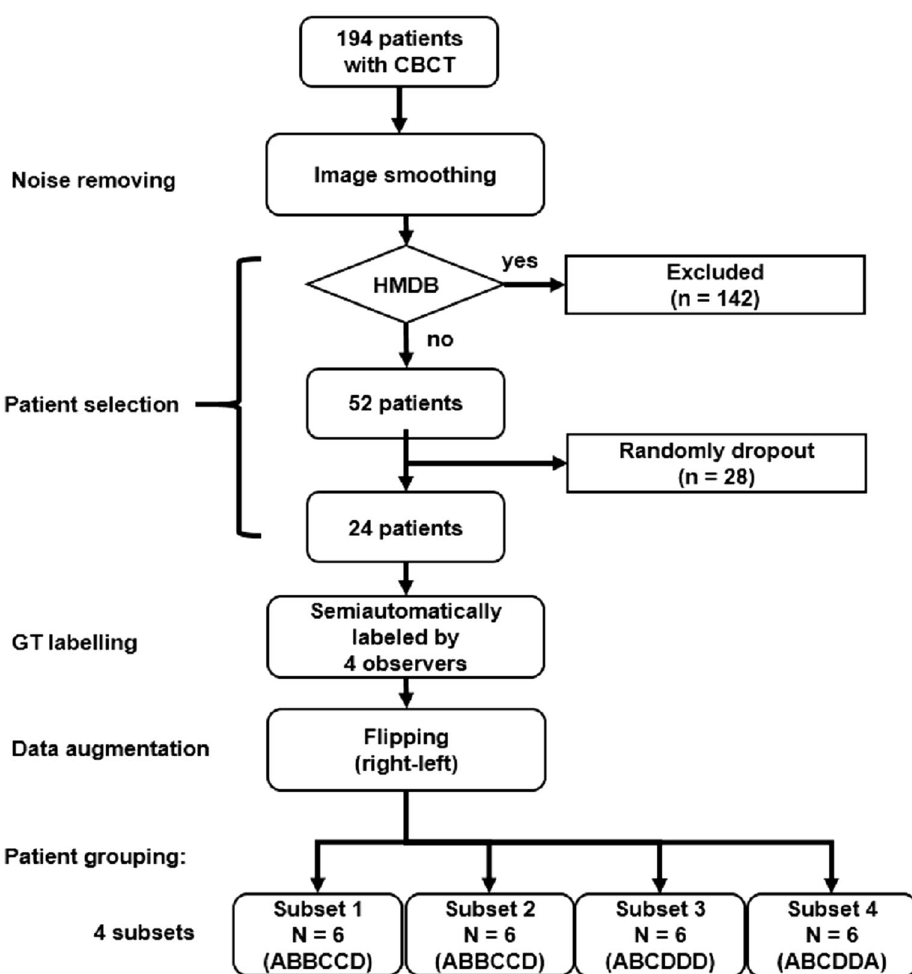
Figure 1. Flowchart describing noise removing, patient selection, GT labeling, data augmentation and patient grouping of this study. CBCT denotes cone beam computed tomography, GT denoted ground truth, and HMDB denotes heavy metallic dental burden. ABCD in subsets denotes observer A, B, C, D,